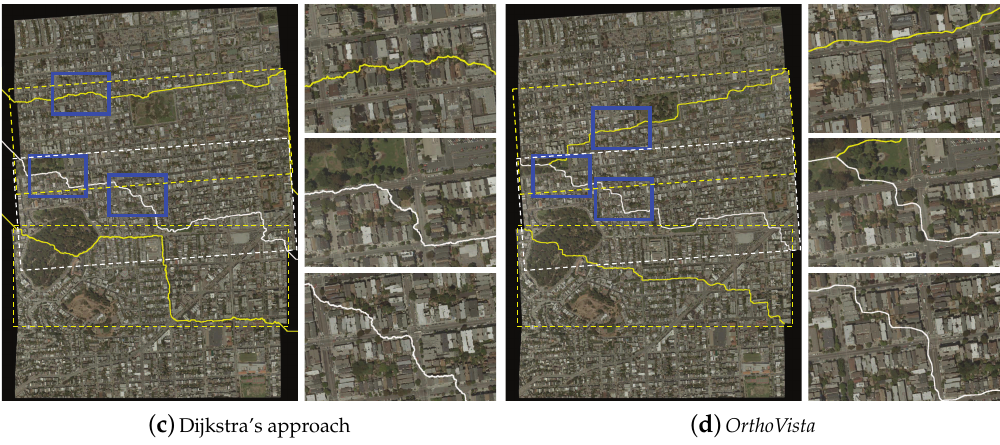
Figure 13. The seamlines detected by our proposed approach ( a ); Li et al. [5] ( b ); Dijkstra’s approach ( c ) and OrthoVista ( d ) on the second group of images. The dash boxes represent the overlapped regions between input images.